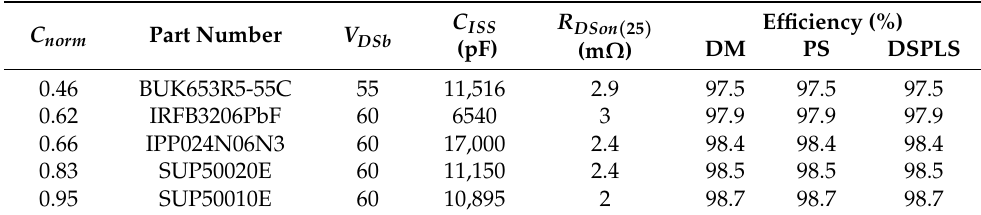
Figure 14. Pareto front considering MOSFETs with V DSb > 40 V, for 800 W. Table 11. Comparison of solutions with the same part number in all positions considering only MOSFETs with V DSb > 40 V for all modulation techniques for 800 W. Reference values: C ref = 1, η ref =